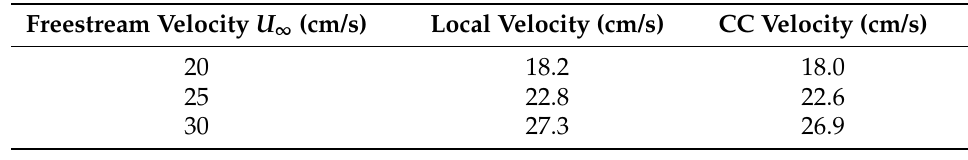
Table 2. Results of the measured convection velocity by CC of whiskers w1 and w5, the latter being situated inside of the influence of the bow wake. Local reference velocity at location w5 is taken from the LES simulations in Figure 3.